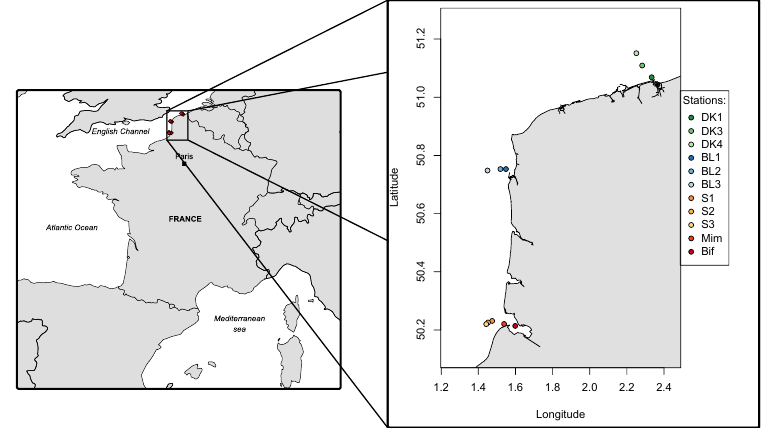
Figure 1. Map of the stations used in the